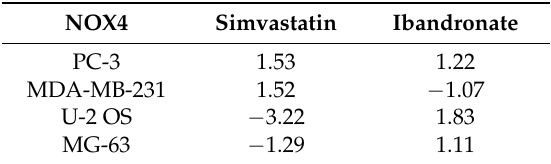
Figure 2. Effect of statin and bisphosphonate on NADP(H) production. Cell lines were treated with EC50-associated concentrations of simvastatin (Sim, 1 µ M for PC3, 0.5 µ M for MDA-MB-231, 3 µ M for U-2 OS, and 10 µ M for MG-63) or ibandronate (Ibn, 50 µ M for all cell lines) for 72 h. Then, concentrations of NADP + ( A ) and NADPH ( B ) were analyzed using the NADP/NADPH Glo Assay (Promega) and the NADPH/ NADP + ratio was calculated ( C ). The “fold”–ratio is given on the y -axis. Bars represent the mean ± SD; * p < 0.05, ** p < 0.01, *** p < 0.001, control (Con) vs. treatment; † p < 0.05, †† p < 0.01, ††† p < 0.001, Ibn vs. Sim; n = 4. Table 7. Fold regulation of NADPH-oxidase NOX4